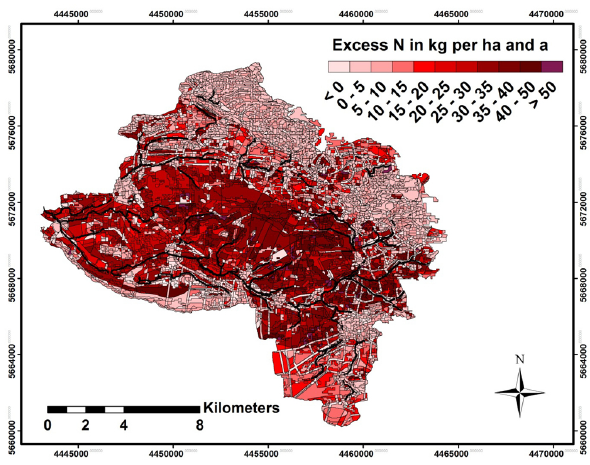
Fig. 3. Modeled excess nitrogen output in kgNha − 1 a − 1 for each HRU of the Lossa catchment. Each HRU is framed by a black line. The bold black lines are buffer strips also represented as (small) HRUs.